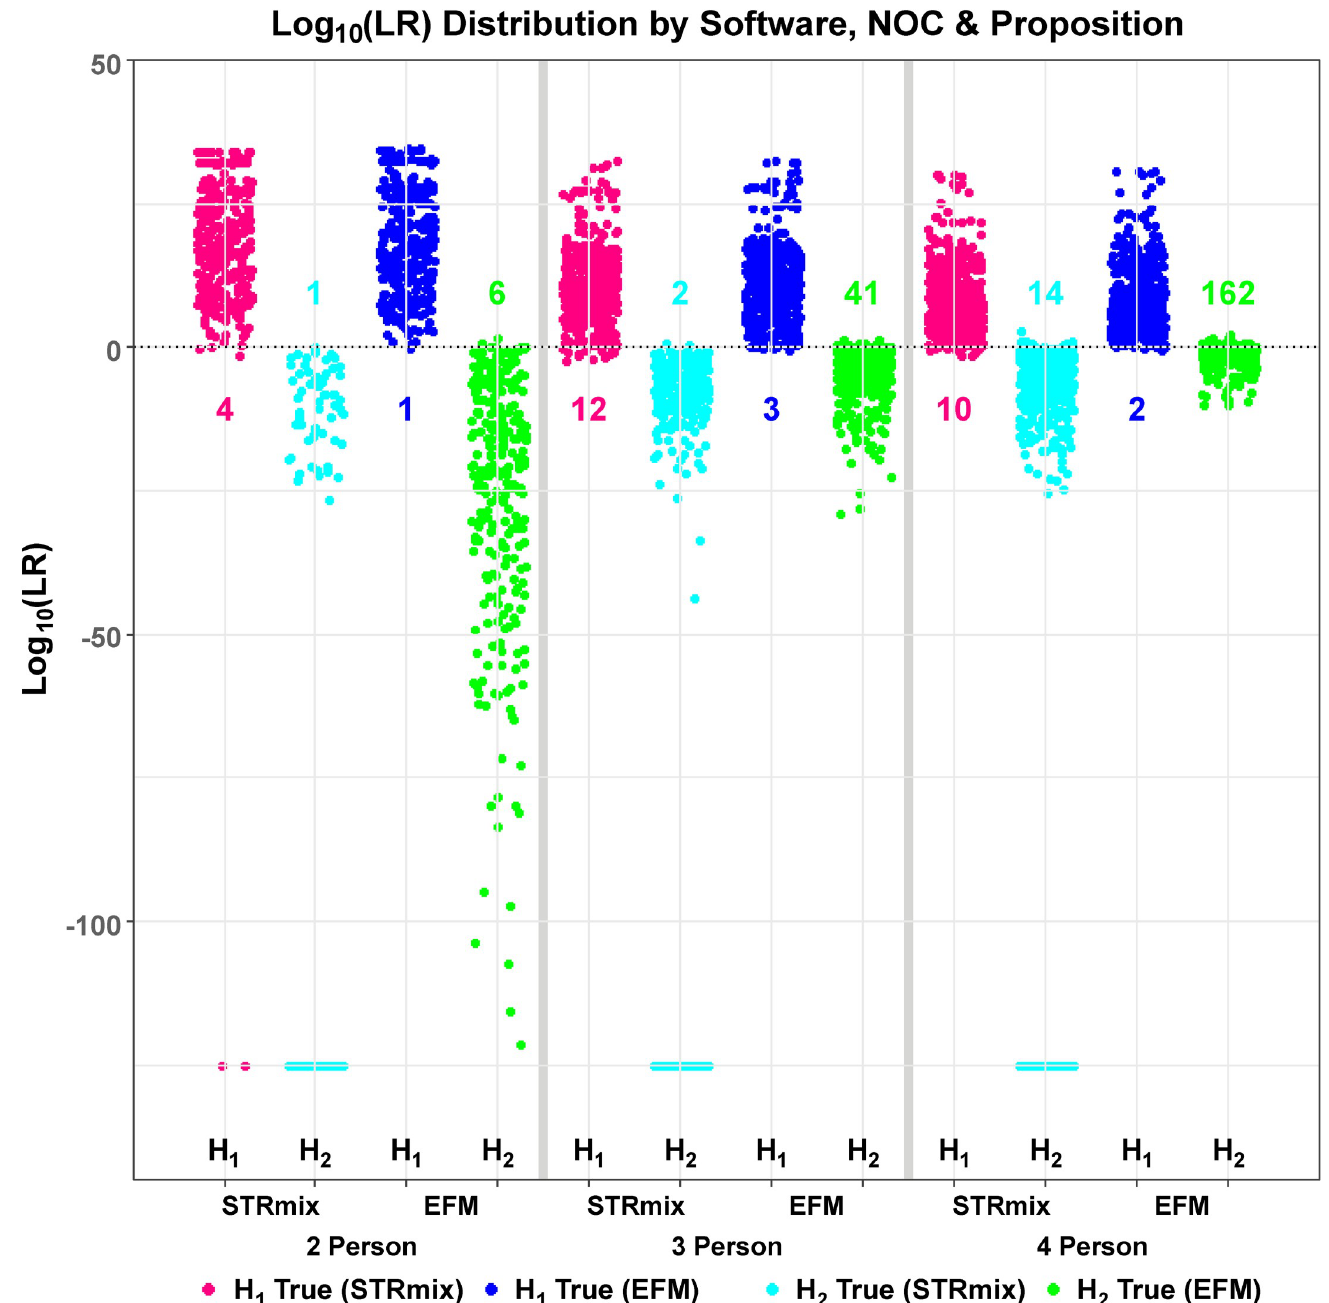
Fig 2. Distribution of log 10 (LR) values for H1-true and H2-true tests assessed by STRmix and EFM for two, three, and four person mixtures. The x-axis shows the labels of propositions (H1 and H2), software (STRmix and EFM), and the NOC = 2 Person, 3 Person, and 4 Person. LRs are plotted on the y-axis as log 10 (LR) values. All samples from different mixture ratios, total DNA template amounts, and DNA treatments are built into this global/overall distribution plot. The plot contains a total of 308 H1-true tests and 308 H2-true tests for the 2P analysis, 441 H1-true and 441 H2-true calculations for the 3P analysis, and 508 H1-true and 508 H2-true tests for the 4P mixtures. STRmix provides an LR value of 0 for excluded loci resulting in profile LR of 0, while EFM gives a non-zero LR value (generally very close to zero). Profiles with LR results of 0 from STRmix are plotted at − 125 on the log 10 scale. �� Two H1-true test interpretations of 2P mixtures for which STRmix assigned profile LRs of 0 (plotted at H1 true STRmix NOC = 2 Person in magenta at − 125 on the log 10 scale and discussed in detail in Section 3.6).